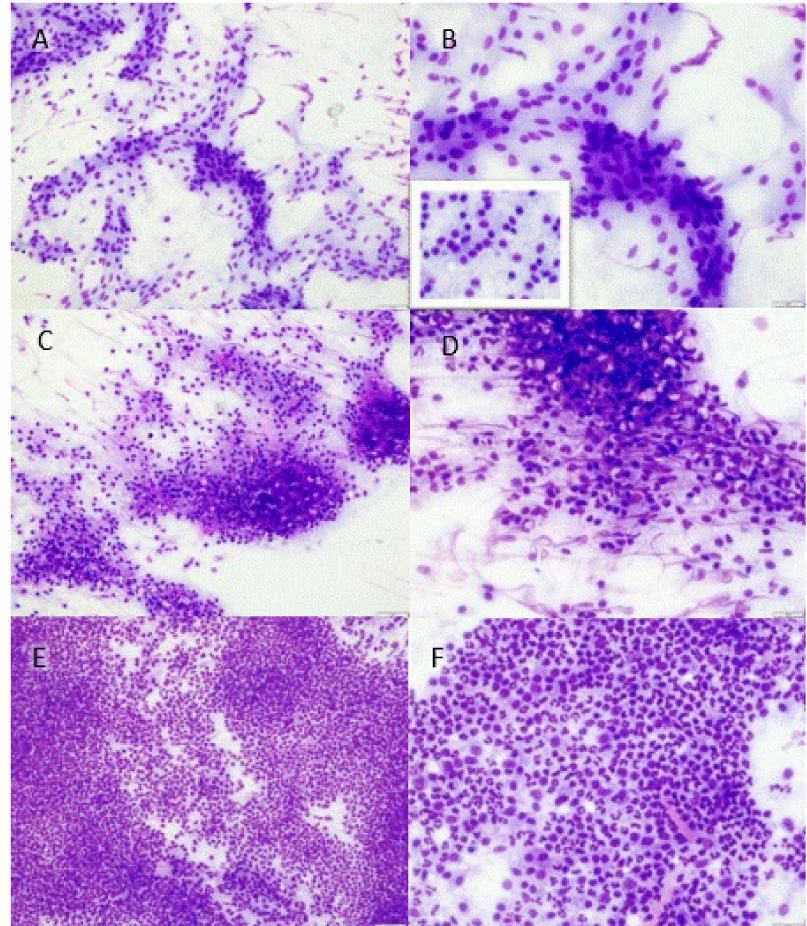
Figure 1. Hemacolor ® staining of leptomeningeal smears of pigs, shown according to abundance of neutrophils: ( A , B ) low, ( C , D ) moderate, and high ( E , F ). ( A , B ) Monomorphic flat to sometimes cuboidal (inset) cells within small amounts of extracellular matrix (fibroblasts with collagen). Neu- trophils are rarely present (<5 per 400 × magnification area) and are not visible in the selected areas for the photo panel (200 × ( A ) and 400 × ( B )); ( C , D ) areas with neutrophils (5–100 per 400 × magnification area), mixed with areas of fibroblasts and collagen and sometimes other, more heterogeneous cell clusters (likely mononuclear inflammatory cells) (200 × ( C ) and 400 × ( D )); ( E , F ) large numbers of neutrophils (>100 to ‘uncountable’), obscuring other potentially present cells (200 × ( E ) and 400 × ( F